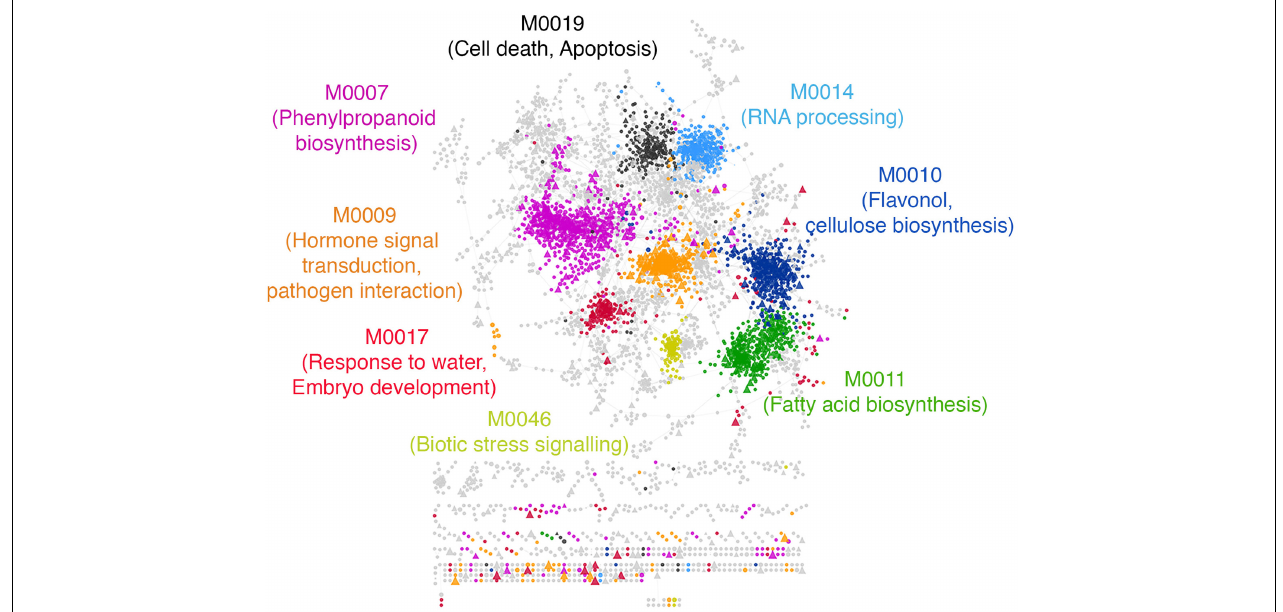
FIGURE 6 | Functional characterization of predicted drought resistance transcription factors. A subset of modules with the highest feature importance scores from the drought classifier were extracted and labeled as ‘drought modules.’ The drought modules consist of a total of ∼ 6000 genes. The network shows the top 5% edges induced between them. Every circle is a functional gene, and triangles are TFs. Genes within a module are similarly colored, and the GO BP enriched within each module is labeled with the same color in the text. Modules with no statistically enriched GO BP terms are colored